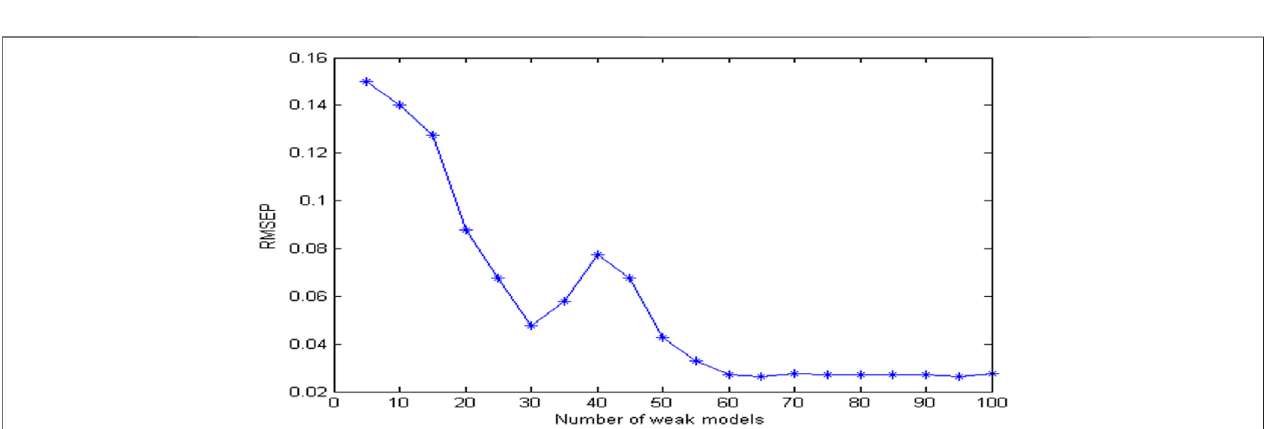
FIGURE 7 | The relationship between the estimation error and the number of weak models.